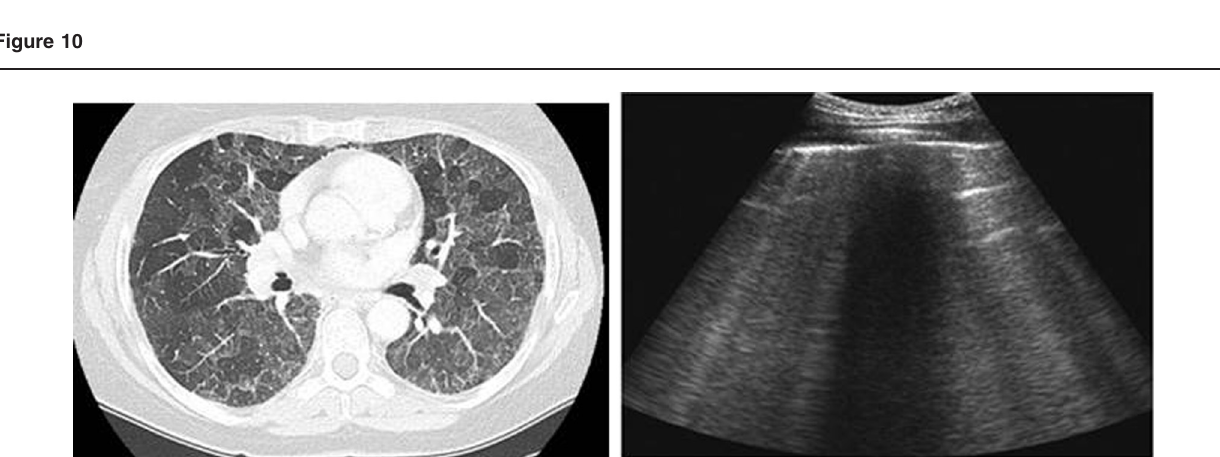
HRCT chest of a patient with HP showed ground-glass opacity. Ultrasound of the same patient showed diffuse B-lines with a narrow distance between them (about 3mm). HP, hypersensitivity pneumonitis; HRCT, high-resolution computed tomography.